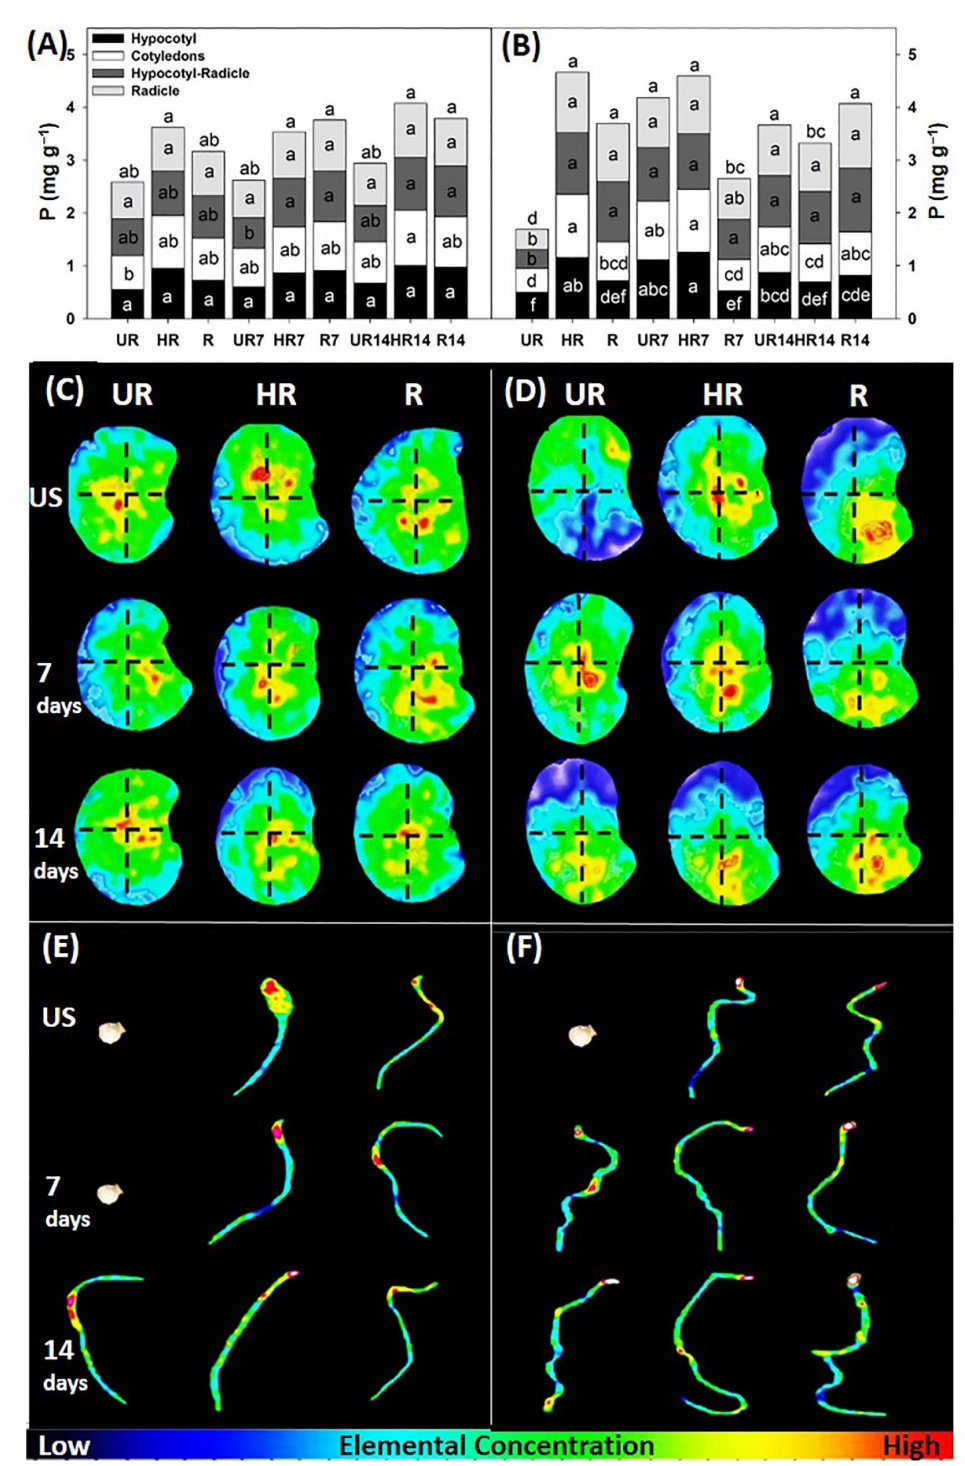
Figure 4. P concentration in seeds pre-imbibition ( A ) and post-imbibition ( B ), P distribution in habanero pepper seeds pre-imbibition ( C ) and post-imbibition ( D ), habanero seedlings at 10 ( E ) and 14 days ( F ) after sowing, of seeds of unripe (UR), half-ripe (HR), and ripe (R) fruits; unstored (US) and stored for 7 and 14 days postharvest. Colors in panels ( C – F ) are based on a relative intensity scale (reported at the bottom of the figure) generated on the intensity of the X-ray fluorescence K α peak of P in the samples. Data are means. Different letters indicate statistically significant differences among treatments (Duncan, p ≤ 0.05, n =